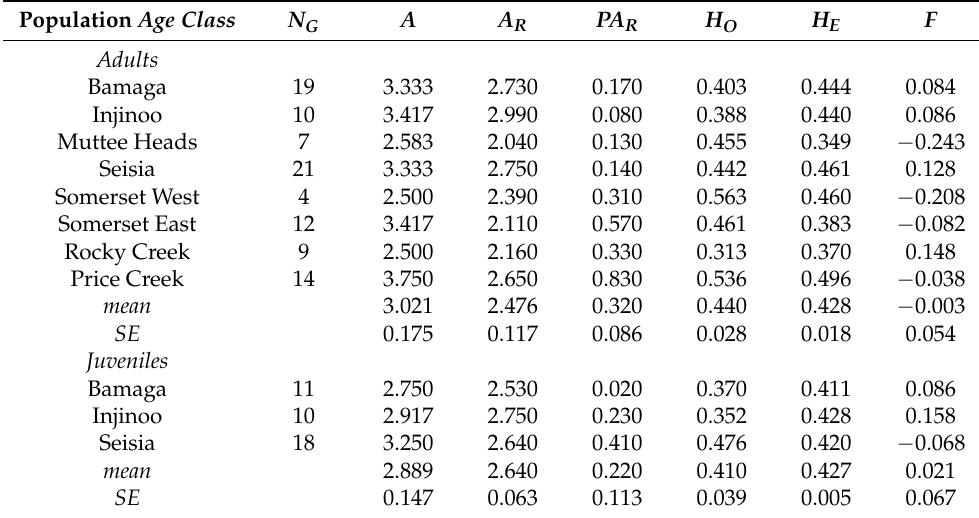
Table 2. Summary of genetic measures for the 135 unique MLG individuals sampled from eight populations of S. lanceolatum from Cape York (Queensland,